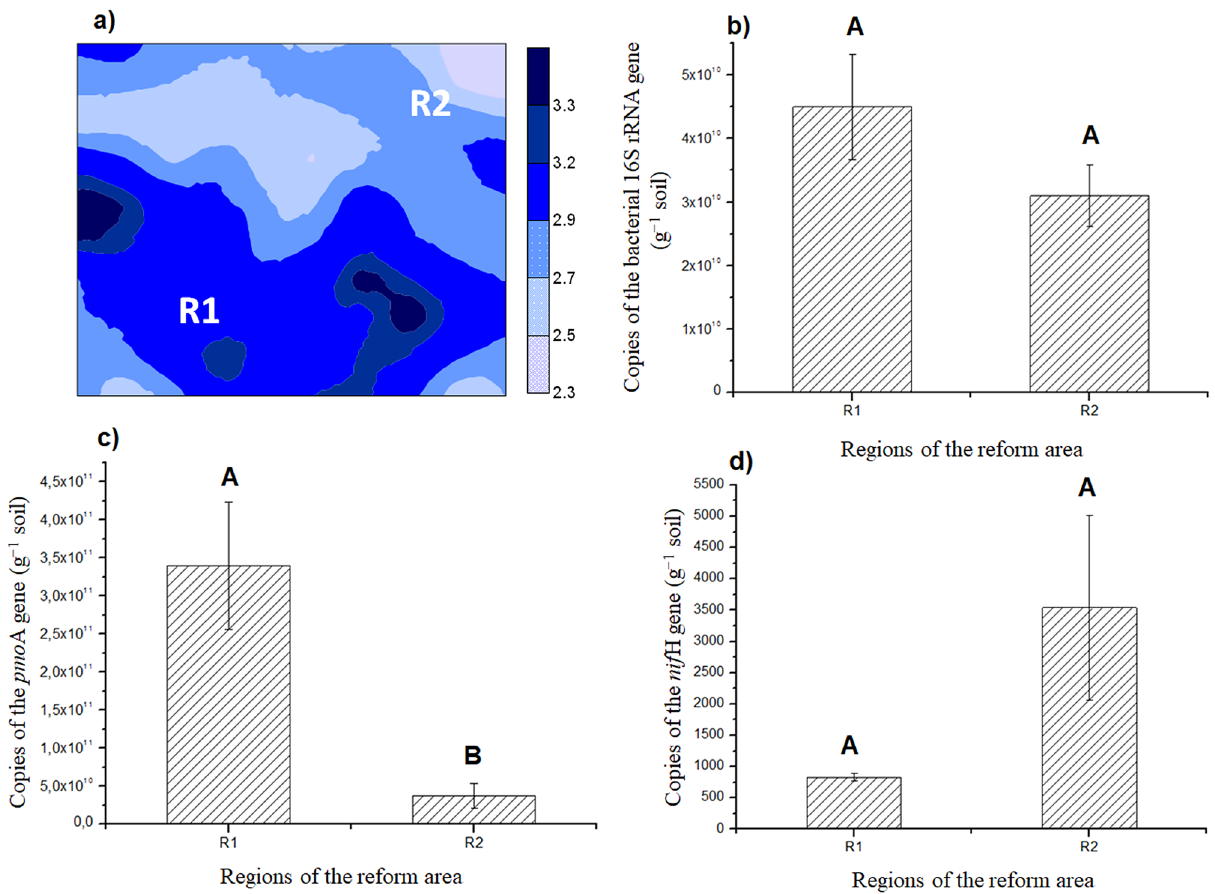
Figure 2. Spatial distribution of FCO 2 (µmol m −2 s −1 ) with identification of two distinct regions in the sugarcane field reform area (R1 and R2) ( a ), graphical representation of both regions with the mean ± standard error of the mean of the copy number of the bacterial 16S rRNA ( b ), pmo A ( c ), and nif H genes ( d ). Means followed by the same letter do not differ from each other by the Student’s t test (p <